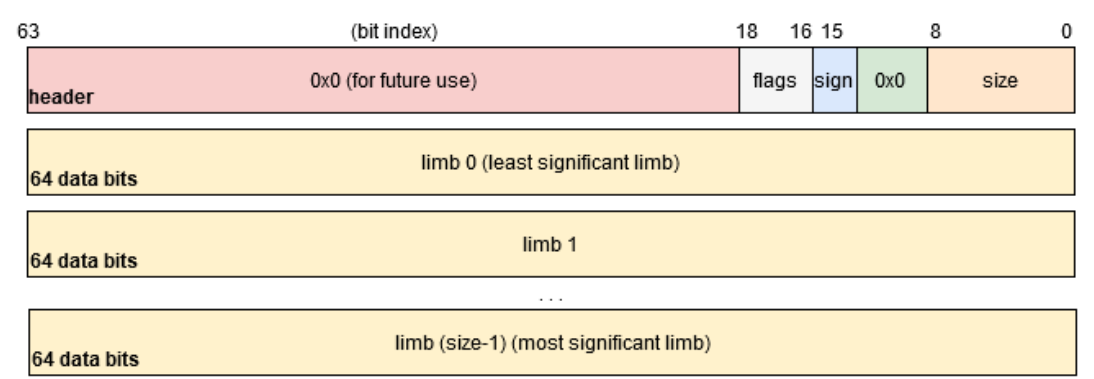
Figure 2. Format of integer numbers in MPA